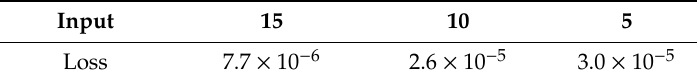
Table 5. Loss of dimension reduction by